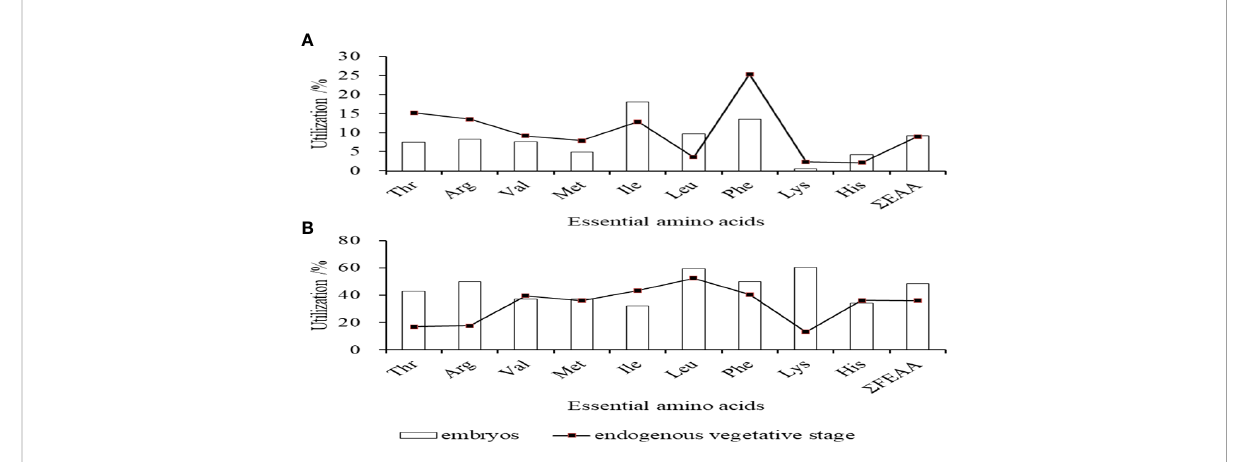
FIGURE 2 Utilization of essential amino acids in embryos and endogenous vegetative stages of cobia (A) in total amino acids; (B) in free amino